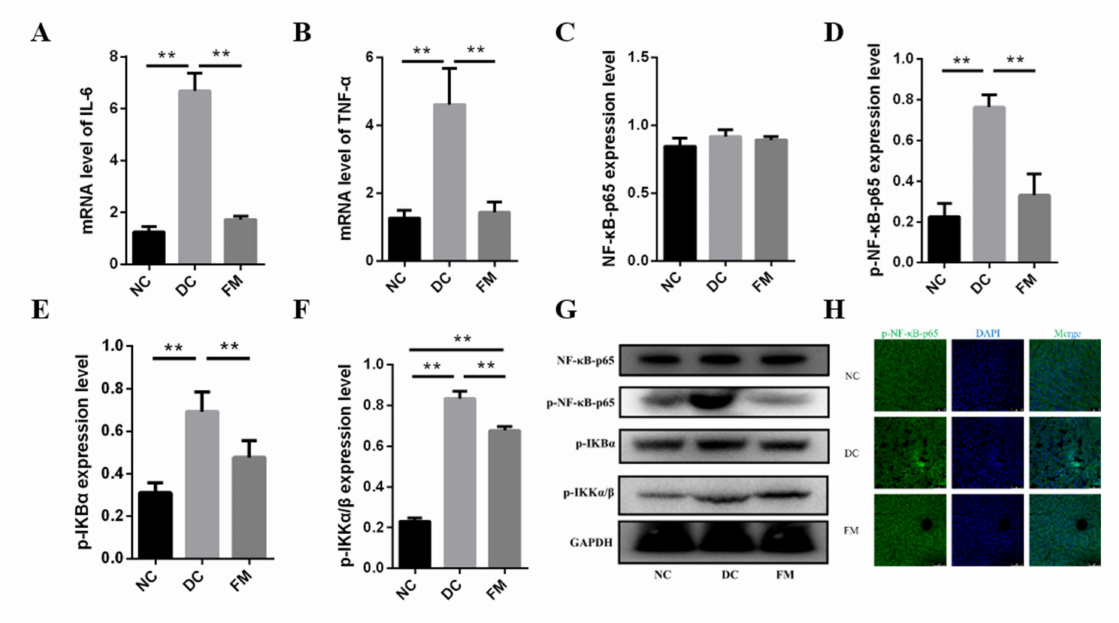
Figure 6. The expression of inflammatory cytokines ( A , B ), core factors in NF- κ B signaling pathway ( C – G ), and nuclear translocation of p- NF- κ B-p65 ( H ). Data were represented as mean ± SEM. NC, normal control group; DC, diabetic control group; FM, foxtail millet supplementation group; IKB, κ B kinase; IKK, inhibitor of κ B kinase. Differences between groups were compared using Student’s T -test, * p < 0.05, ** p <